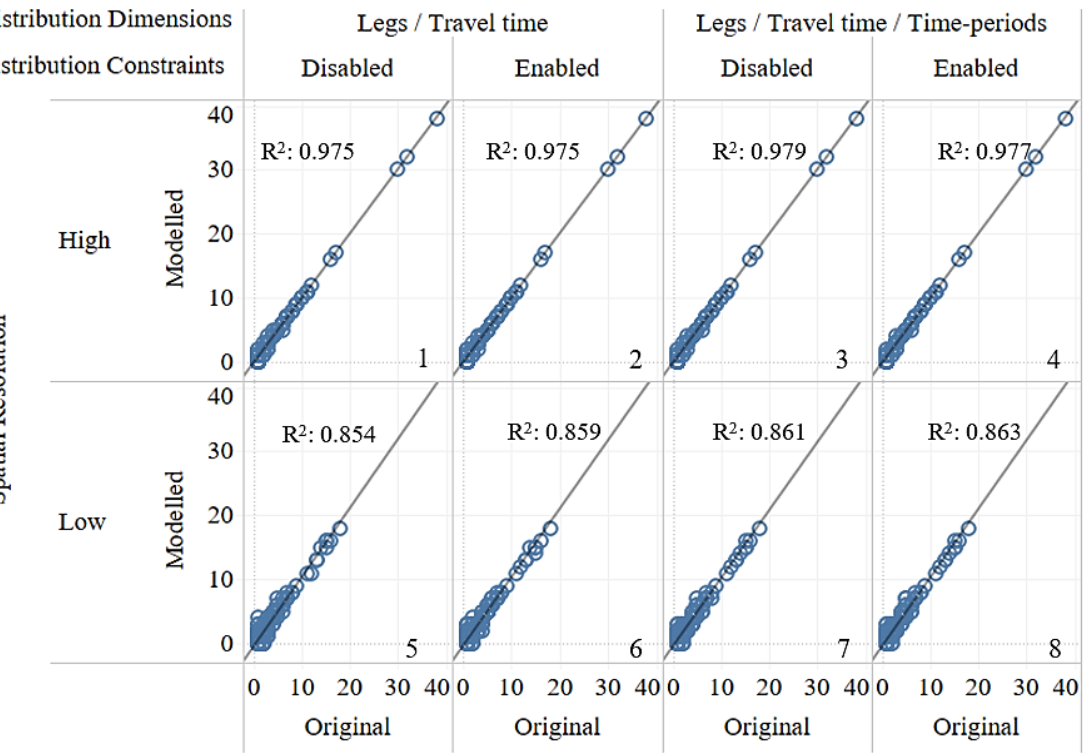
Figure 8. Comparison of zones-sequencing between original and modelled